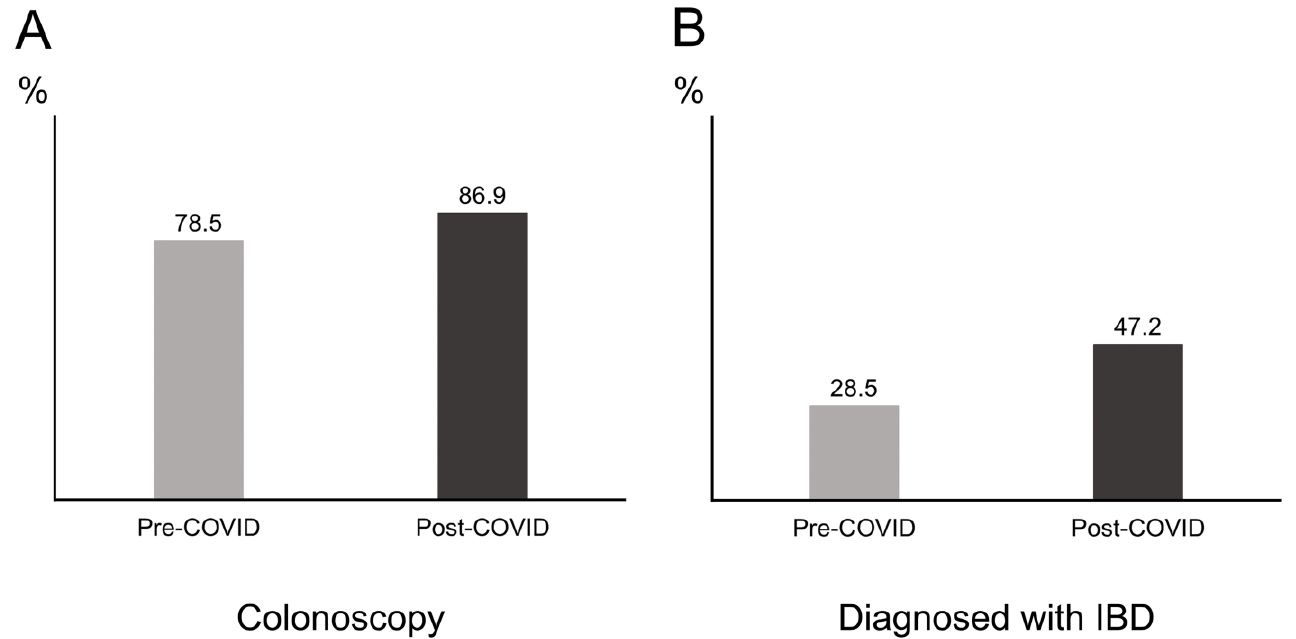
Figure 2. Proportion of patients between groups divided according to the pre- and post-coronavirus infectious disease 2019 (COVID-19) era. ( A ) Proportion of patients receiving a colonoscopy. ( B ) Pro- portion of patients diagnosed with inflammatory bowel disease (IBD). Table 4. Comparison of indications between patients receiving a LGI endoscopy in the preCOVID- 19 era and postCOVID-19 era.